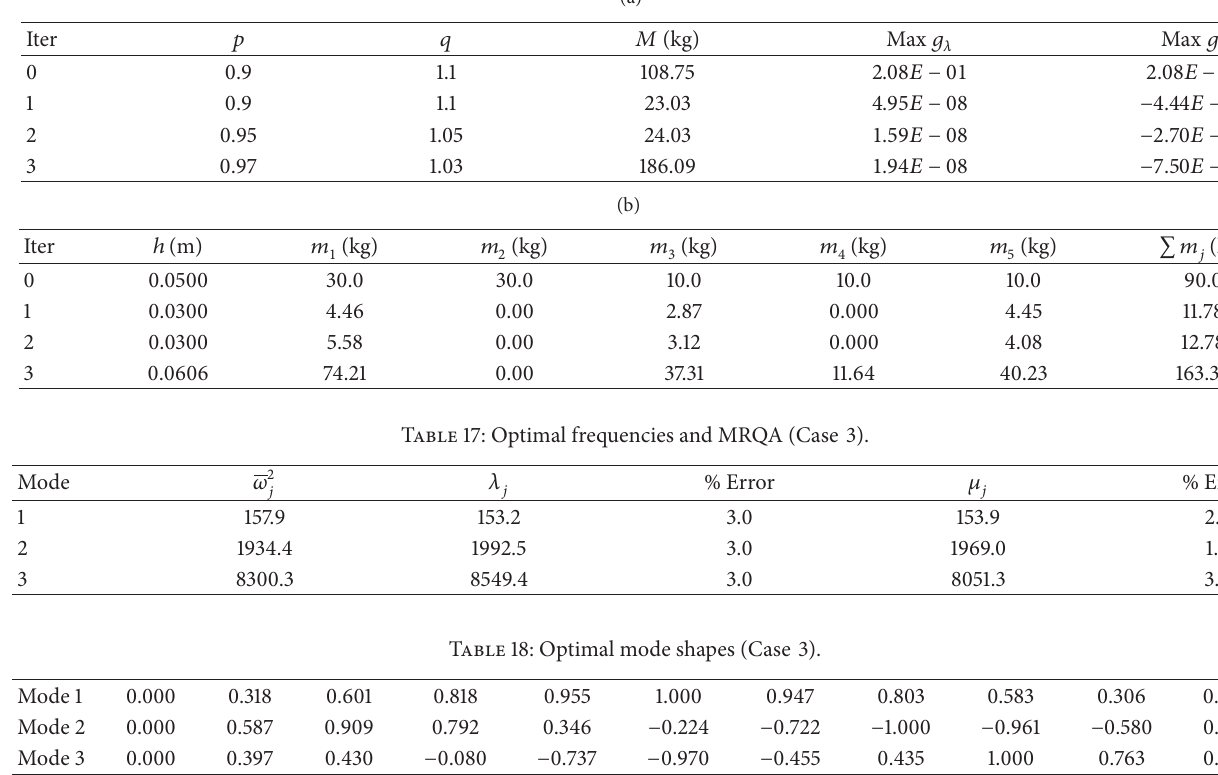
Table 16: Sequential optimization iteration history (Case 3).